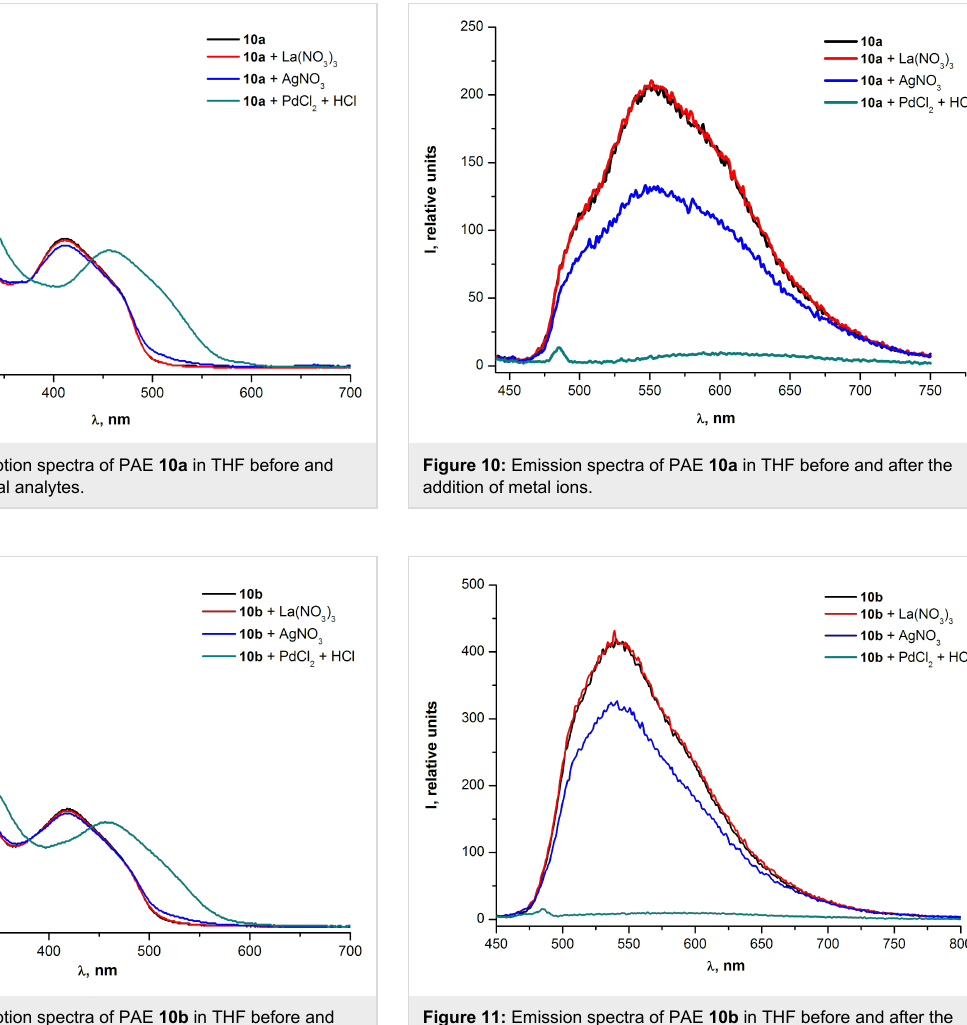
fluorescence intensity after the interaction with a quencher, res- pectively).